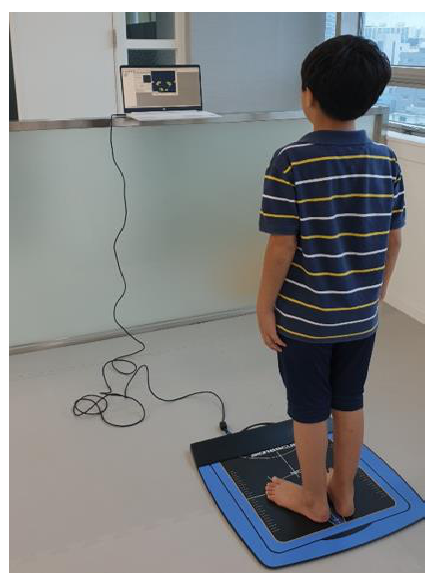
Figure 3. The center of pressure (COP) displacements.